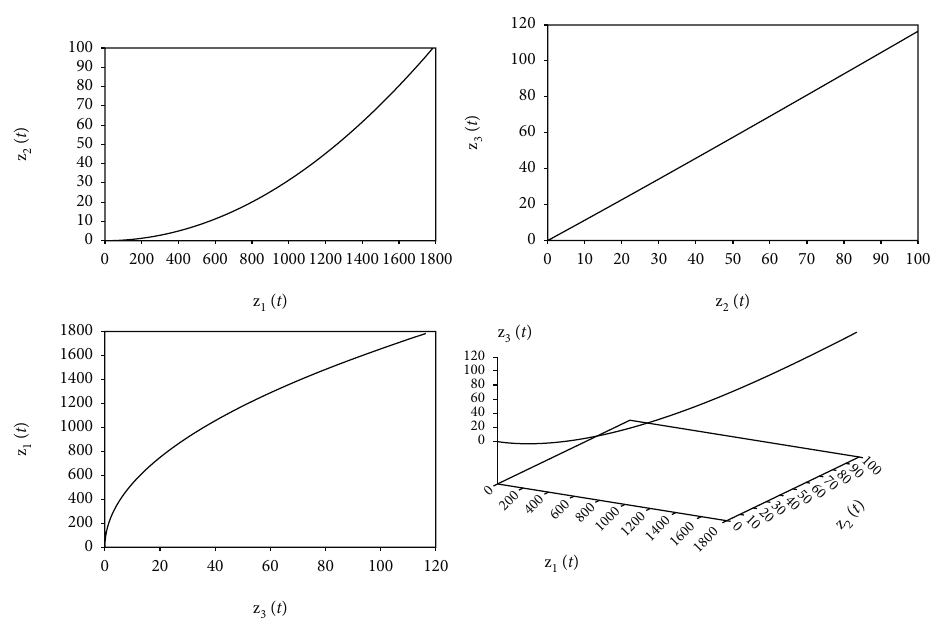
Figure 2: Phase portraits using 9-iteration NIM for impulse input.